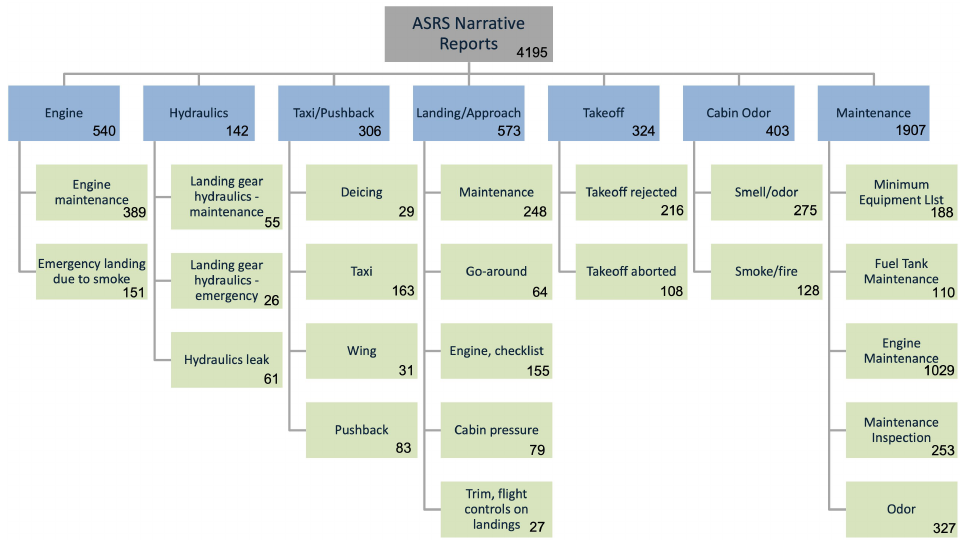
Figure 5. All clusters and subclusters with identified cluster topic and number of